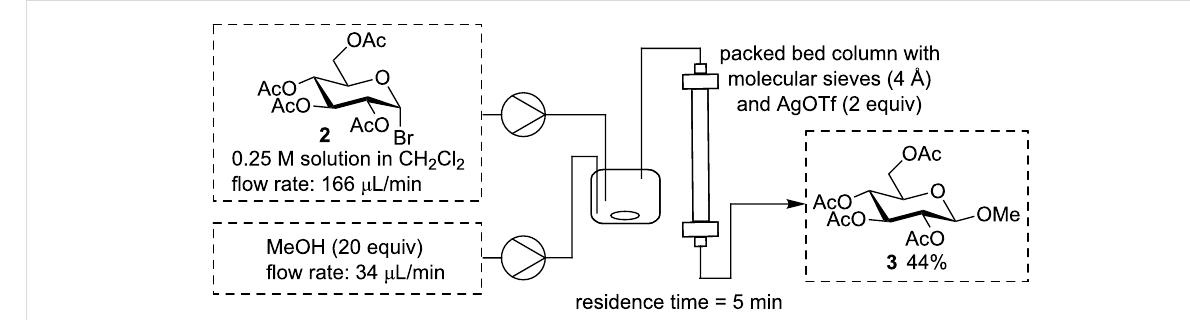
Scheme 2: Flow Koenigs–Knorr reaction to methyl glycoside 3 with silver triflate.